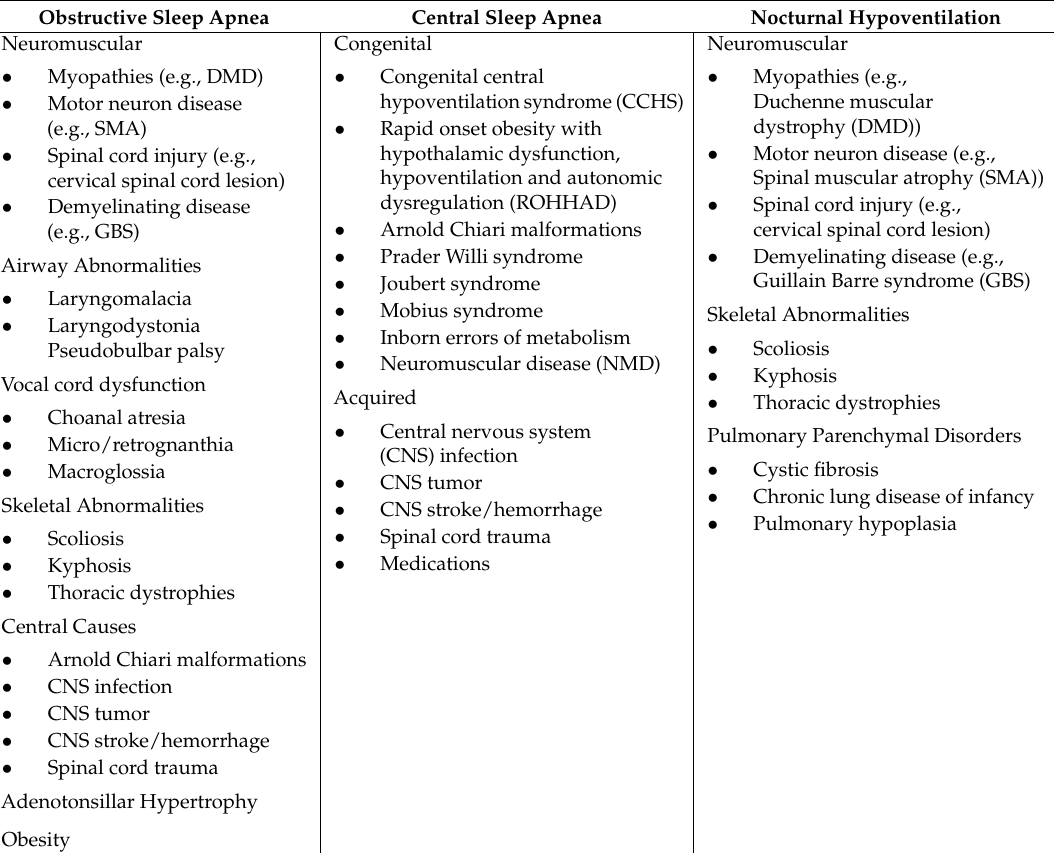
Table 1. Risk factors for sleep disordered breathing